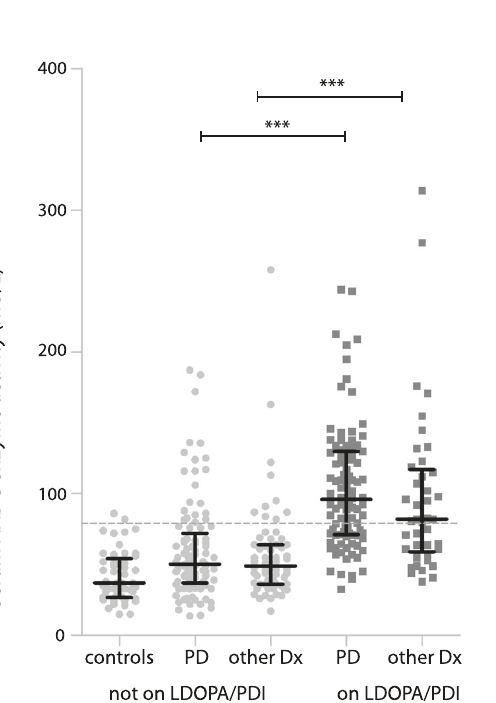
Fig. 1 Serum AADC enzyme activity in non-neurological controls, patients with and without chronic use of levodopa/PDI. AADC enzyme activity is elevated in patients on, compared to patients not on, levodopa/PDI treatment. Median AADC activity is shown with interquartile range. Dashed line: cutoff value of AADC 79 mU/L, based on the 95th percentile of 49 controls free from neurological disease. ***The difference is signi fi cant at the p < 0.001 level (Mann – Whitney U ). 1 data point is outside the axis limits: PD patient on LDOPA/PDI with AADC 663 mU/L. AADC aromatic L-amino acid decarboxylase, LDOPA levodopa, other Dx patients with other neurodegenerative or movement disorder than Parkinson ’ s disease, PD Parkinson ’ s disease, PDI peripheral decarboxylase inhibitor.